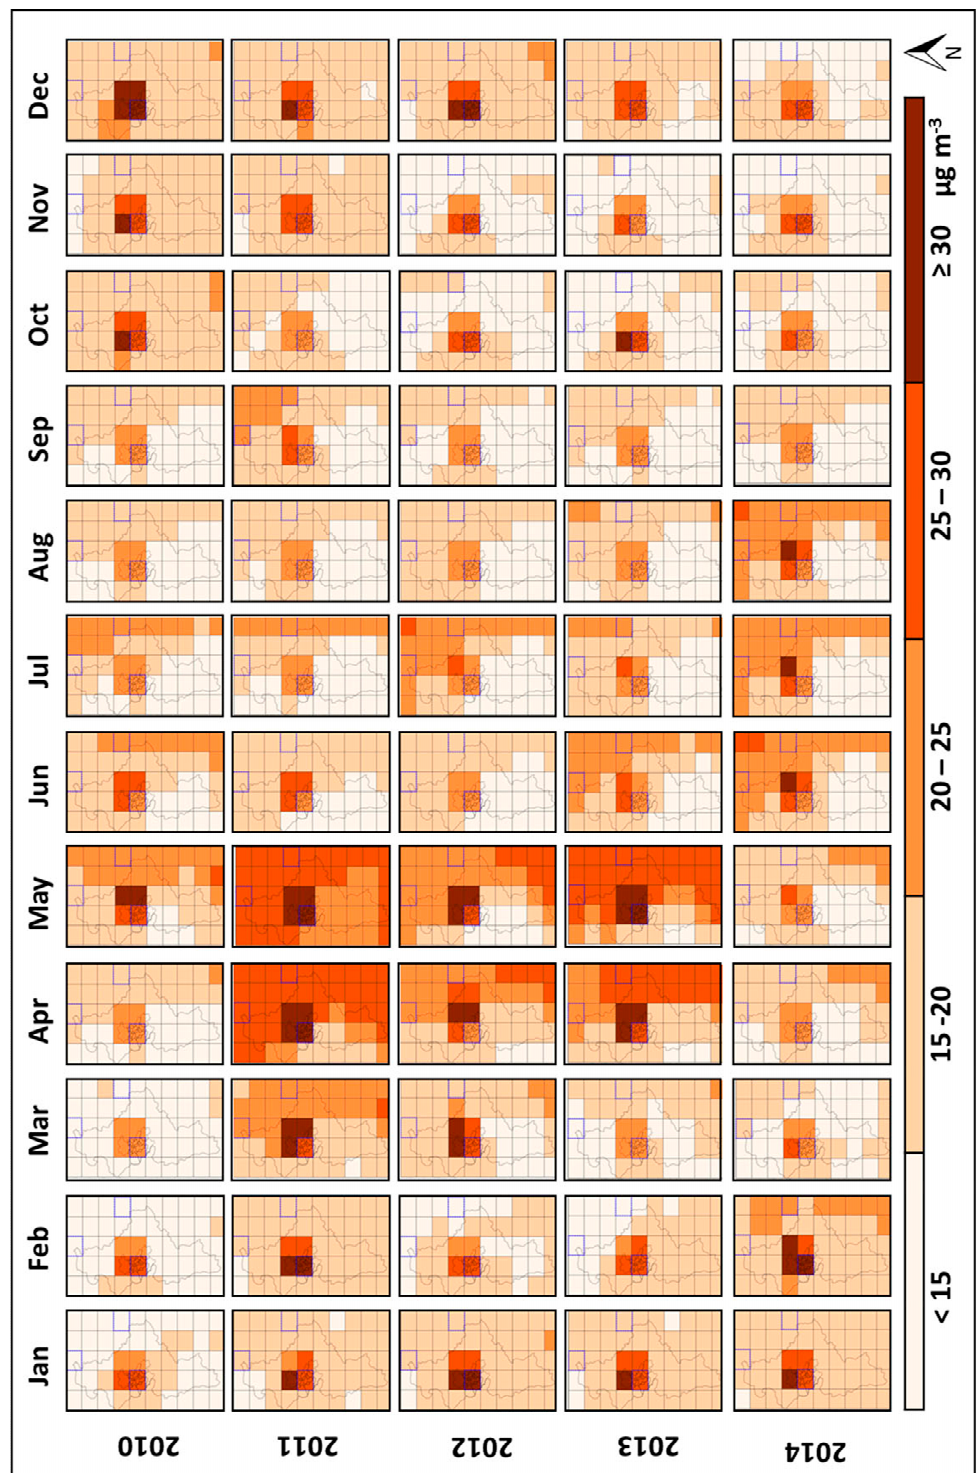
Figure 9. Regional distribution of monthly PM 2.5 means in NEM.